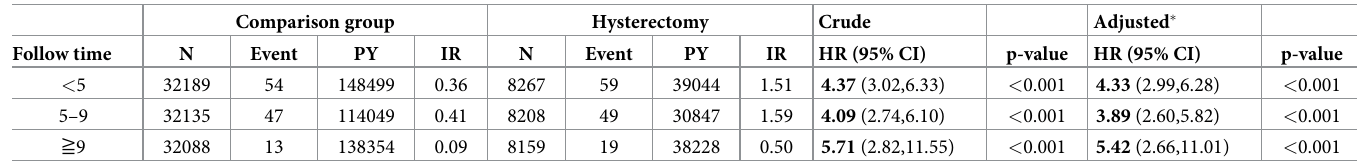
Table 4. Risk of vertebral fracture in women with hysterectomy compared with the comparison group stratified by follow-up year. Comparison